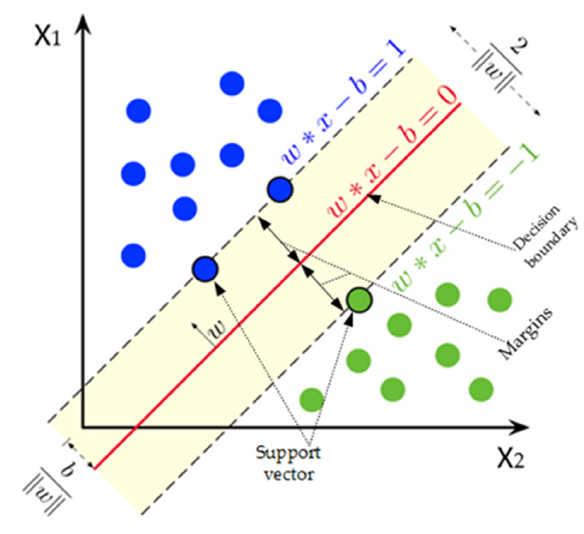
Figure 6. Decision boundary and support vectors in SVM.